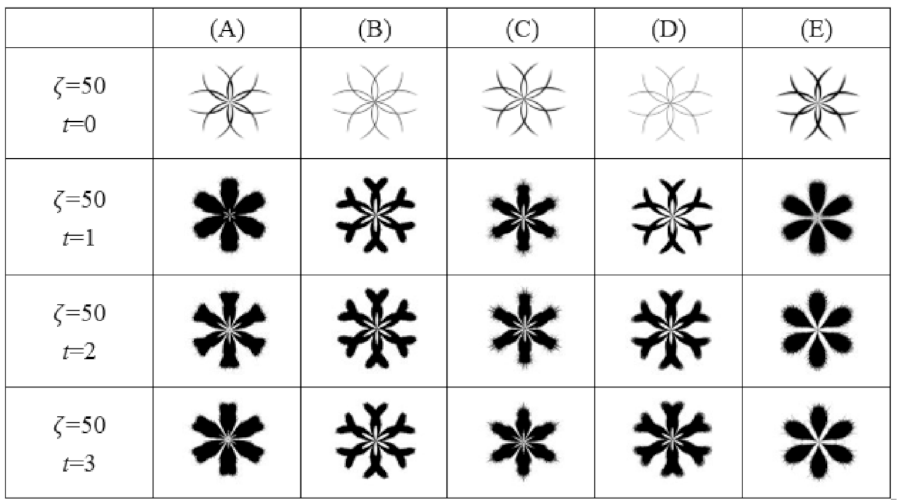
Figure 10. SDP figures in weighting coefficient 50 and time delay coefficient 0 to 3 for five different